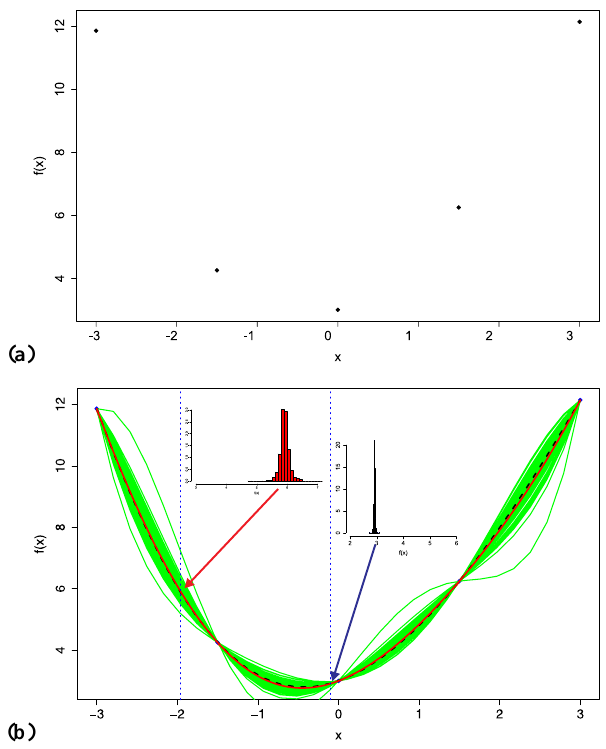
Fig. 2. (a) Five known points from some unknown function f (x) . These five points are used to train the emulator. (b) 600 realisations (green lines) from a one-dimensional emulator based on the five points in (a) . The mean of the emulator (dashed) is used to estimate the true curve (the solid red line) and the spread of the realisations gives visual indication of the emulator uncertainty. The histograms inset show the posterior Gaussian distribution at two points on the curve shown by the arrows, one point is near the training data so the Gaussian distribution is much narrower (the blue